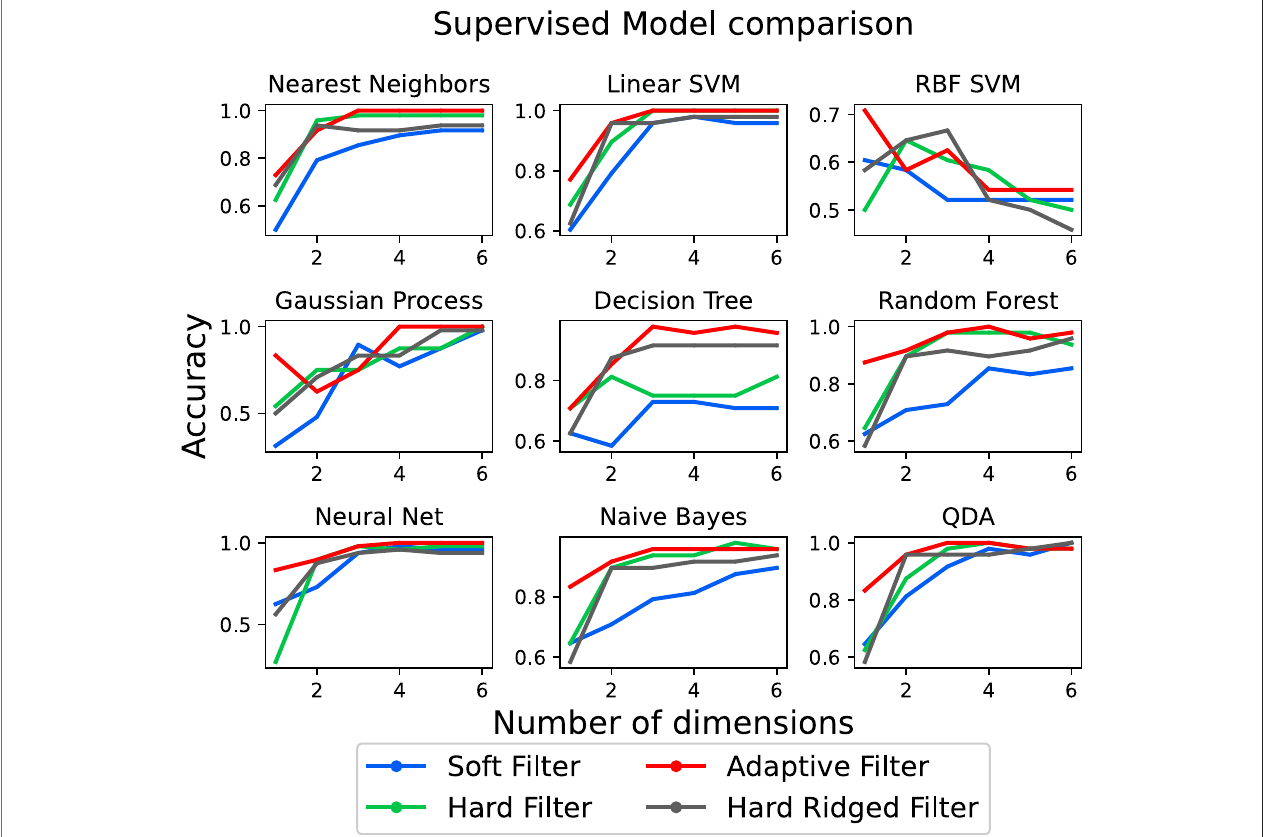
FIGURE 8 | Test accuracy when performing classi fi cation of the different objects using the nine different classi fi ers as a function of the PCA dimensions.